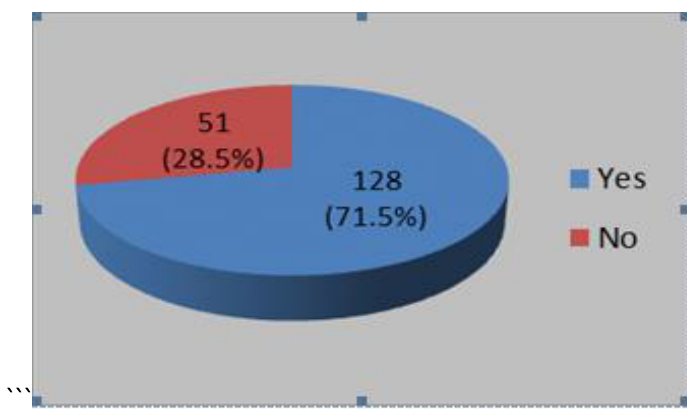
``` Figure 3: Have you or your neighborhood had experience with the municipal court? Source: Survey result, 2019 Table 14: Public perception regarding Municipal court decisions and trials